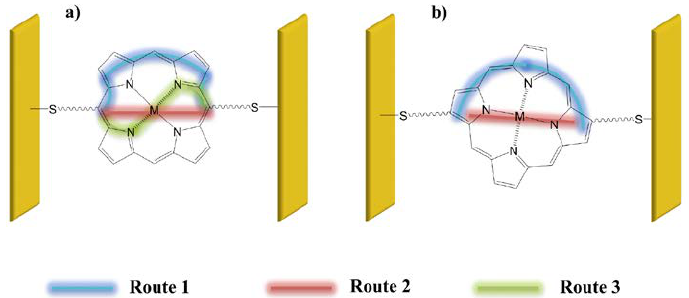
Figure 11. Theoretically possible electron transport pathways in a porphyrin macrocycle with: ( a ) ( a ) meso – meso connections; and ( b ) with β – β connections [30]; diagram after [31], with permission from World Scientific Publishing